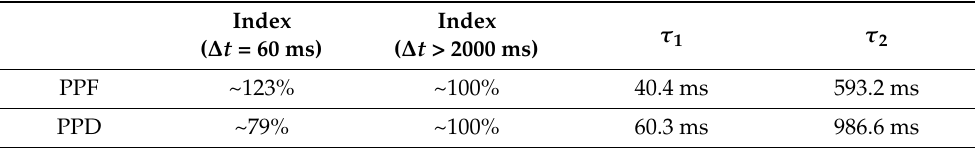
Figure 7. ( a ) Paired-pulse facilitation (PPF) and ( b ) paired-pulse depression (PPD) emulations of SPE-chitosan memristors (interval time ( Δ t ) = 70 ms). ( c ) The PPF and PPD index (the second postsynaptic current peak/the first postsynaptic current peak ( A 2 / A 1 ) in %) as a function of the Δ t in paired presynaptic spikes. The closed circles are the measured data, and the solid line is the result of fitting by the double-exponential decay function. Table 3. Total response parameters in the paired-pulse facilitation (PPF) and paired-pulse depression (PPD) behaviors of SPE-chitosan memristor. τ 1 and τ 2 are the relaxation time constants, and Δ t is the time interval.